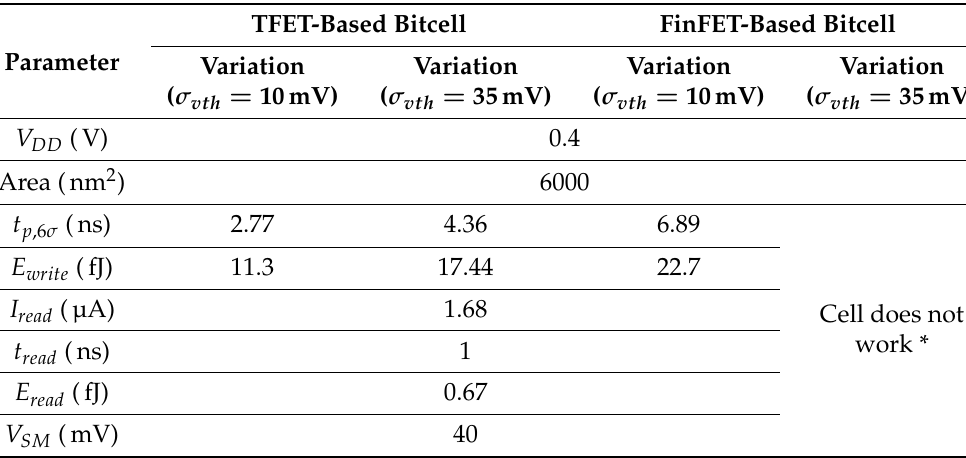
Figure 8. DMTJ-based STT-MRAM bitcell Monte Carlo simulation results for write and read opera- tions ensuring a WER = 10 − 7 and RDR = 10 − 7 , respectively. V DD = 0.4V and σ vth = 10mV. Table 2. Summary of writing (WER = 10 − 7 ) and reading (RDR = 10 − 7 ) performances for TFET- and FinFET-based bitcells operating at V DD =